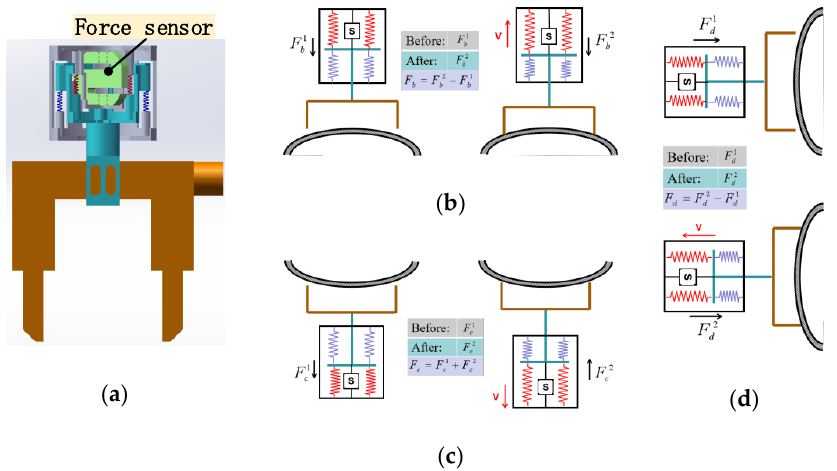
Figure 6. Flexible measurement method. ( a ) Force sensor; ( b – d ) measurement fundamentals.